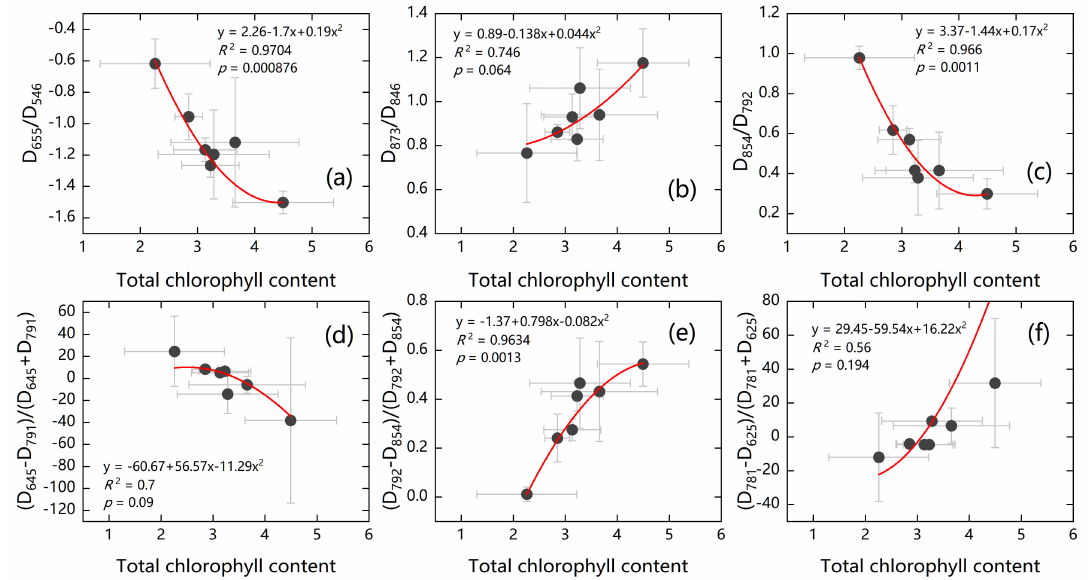
Figure 9. The relationship between the chlorophyll content of Suaeda salsa and the best vegetation indices D 655 / D 546 ( a ), D 873 / D 846 ( b ), D 854 / D 792 ( c ), (D 645 − D 791 ) / (D 645 + D 791 ) ( d ), (D 792 − D 854 ) / (D 792 + D 854 ) ( e ) and (D 781 − D 625 ) / (D 781 + D 625 ) ( f ). The error bars represent the standard error of the mean of total chlorophyll content and various red edge parameters (n = 3). The red curve represents a quadratic polynomial